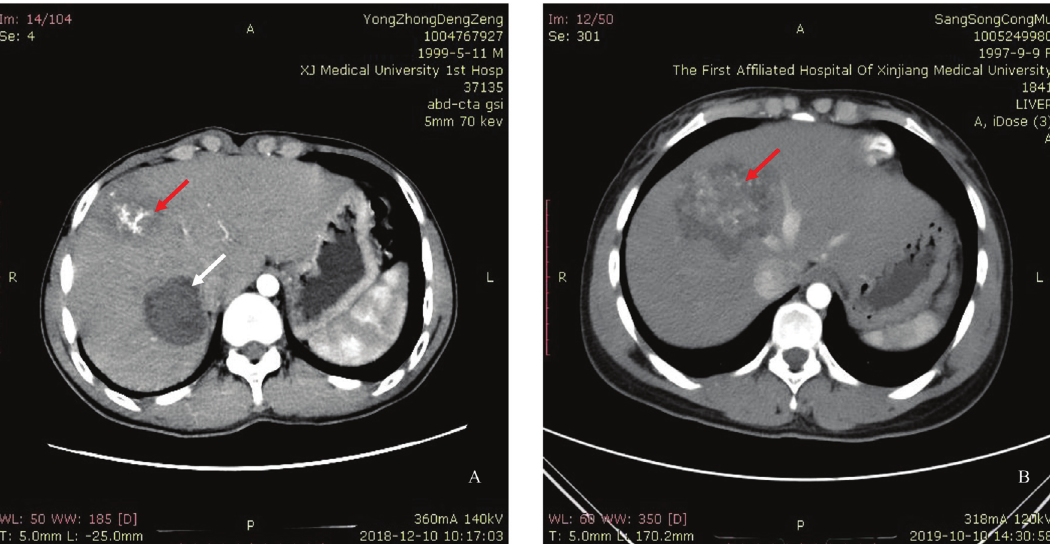
Figure 1. (A) An AE lesion located in the right anterior lobe of the liver (red arrow) and a CE cyst located in the right posterior lobe of the liver (white arrow). (B) The AE lesion is located in the middle liver lobe (red